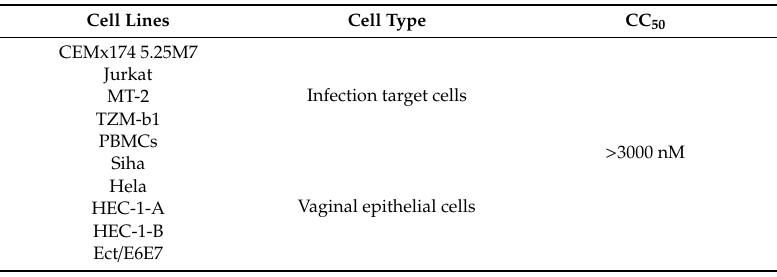
Table 5. In vitro cytotoxicity of SDF-1/54